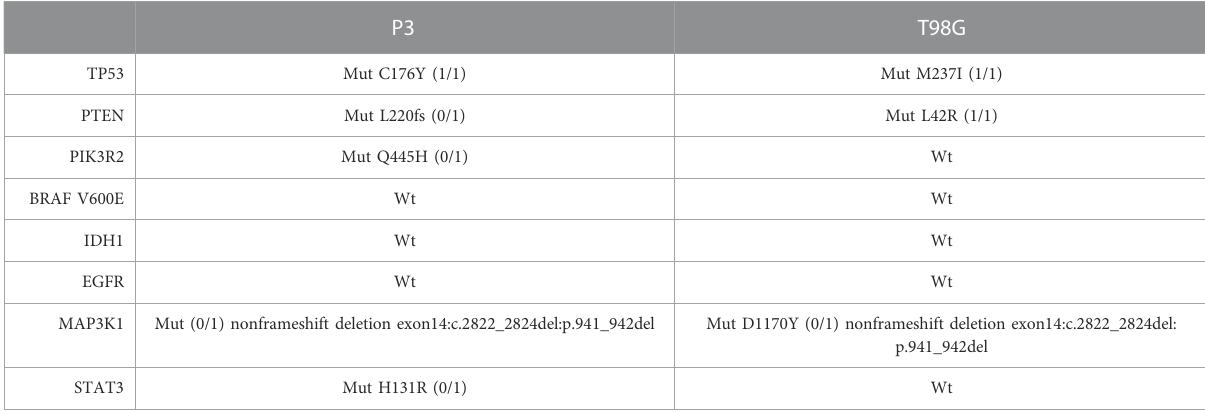
Taken together, pre-treatment with BTZ rescinded GBM cells ’ resistance to TMZ.